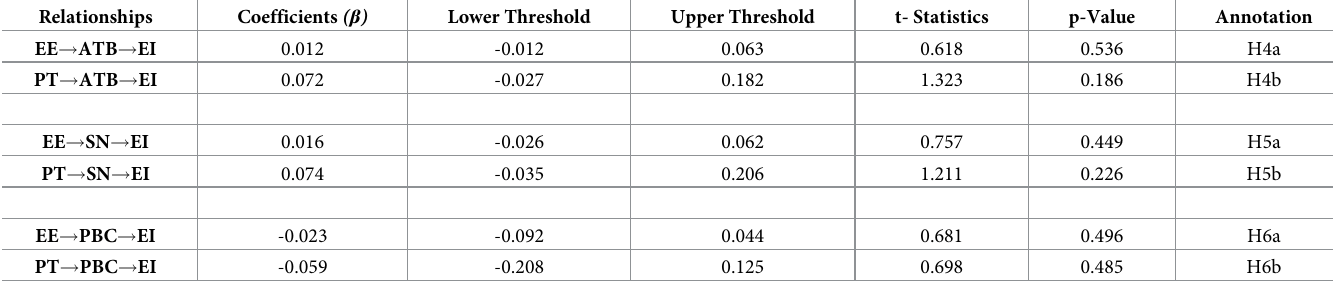
Table 5. Structural specific indirect effects of the female